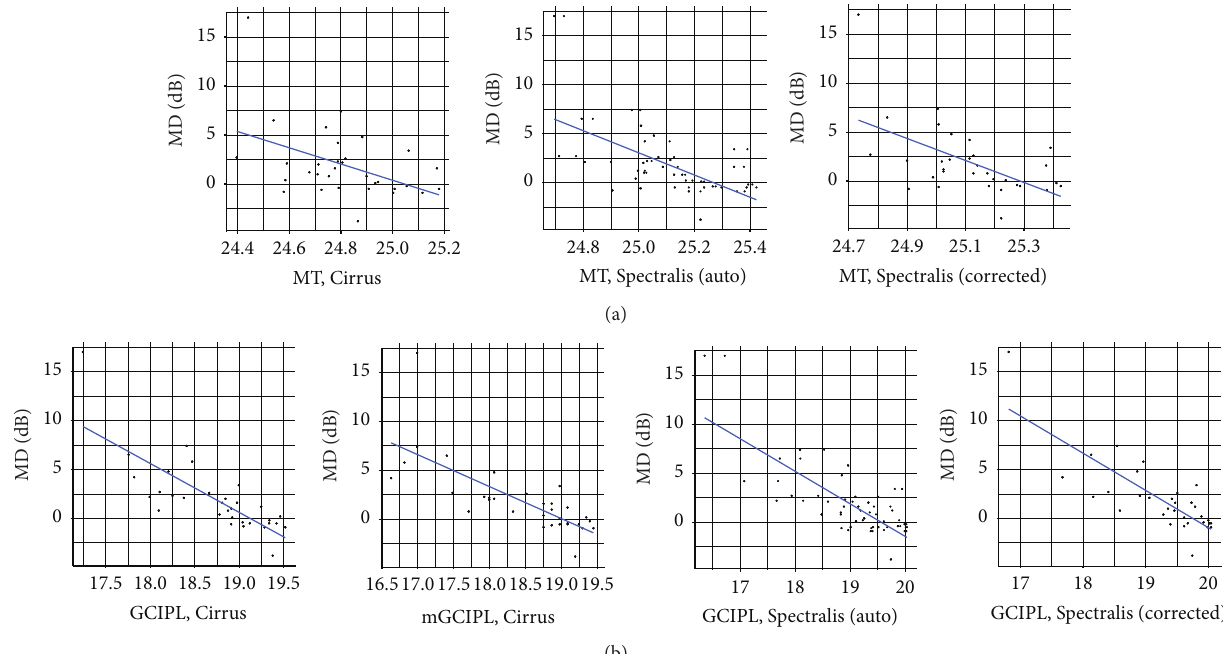
Figure 4: Scattered plots showing the structure-function relationship were obtained using linear models analysis. Age adjustment was applied inallcalculations:toprowfromlefttoright:MDversusmacularthicknessfromCirrus,Spectralis(automaticvalues),andSpectralis(manually corrected values). Bottom row from left to right: MD versus ganglion cell-inner plexiform layer thickness from Cirrus (average and minimum value), Spectralis (automatic values), and Spectralis (manually corrected values). MD: mean